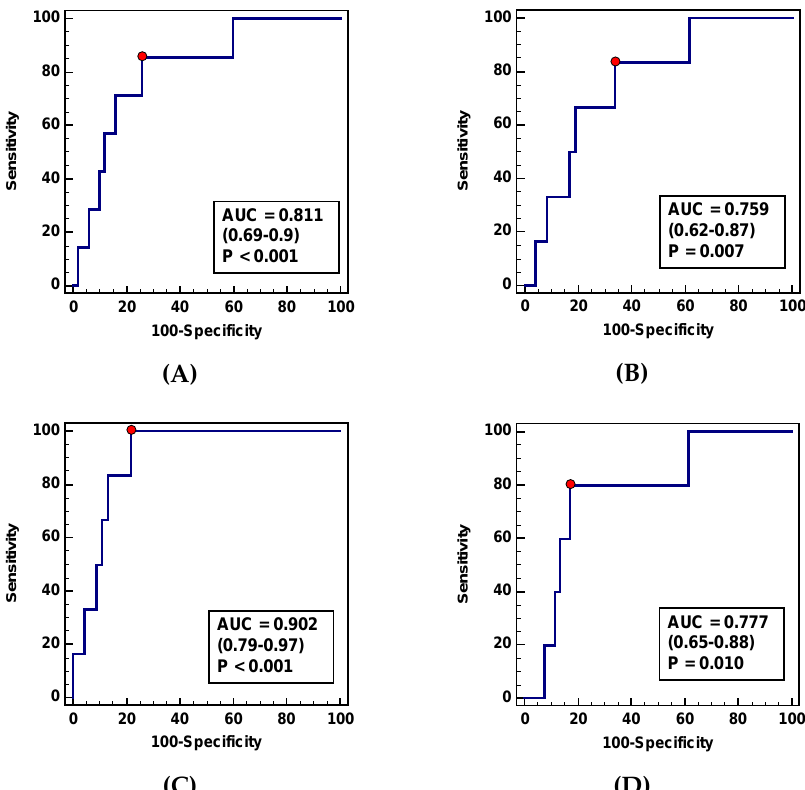
Figure 9. Asymmetric dimethylarginine (ADMA) as a predictor of operative morbidity expressed in terms of the Clavien-Dindo Classification (CDC) ≥ 3 or as predictors of an anastomotic leakage (AL): ( A ) ADMA- ∆ 24 / 8 as a CDC ≥ 3 marker; ( B ) ADMA- ∆ 72 / 8 as a CDC ≥ 3 marker; ( C ) a panel consisting of